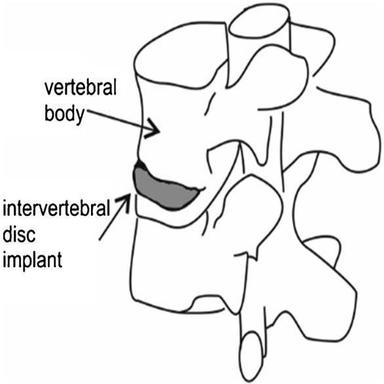
The scheme of the vertebral body and intervertebral disc implant (handdrawn based on many available literature and internet sources).